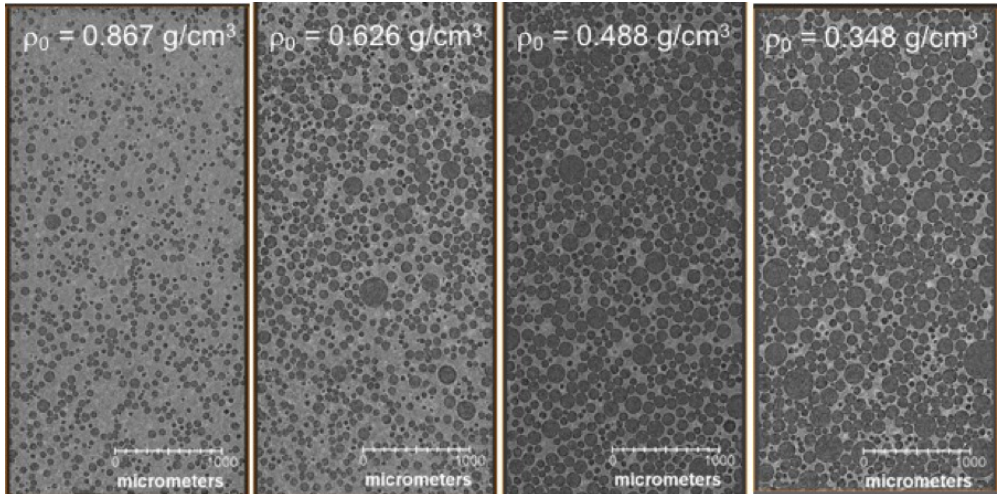
Figure 4. X-ray computed tomographs of PDMI-polyurethane foams with initial densities ρ 0 = 0.867, 0.626, 0.488 and 0.348 g/cm 3 . Taken from Ref. [6], reprinted with permission.